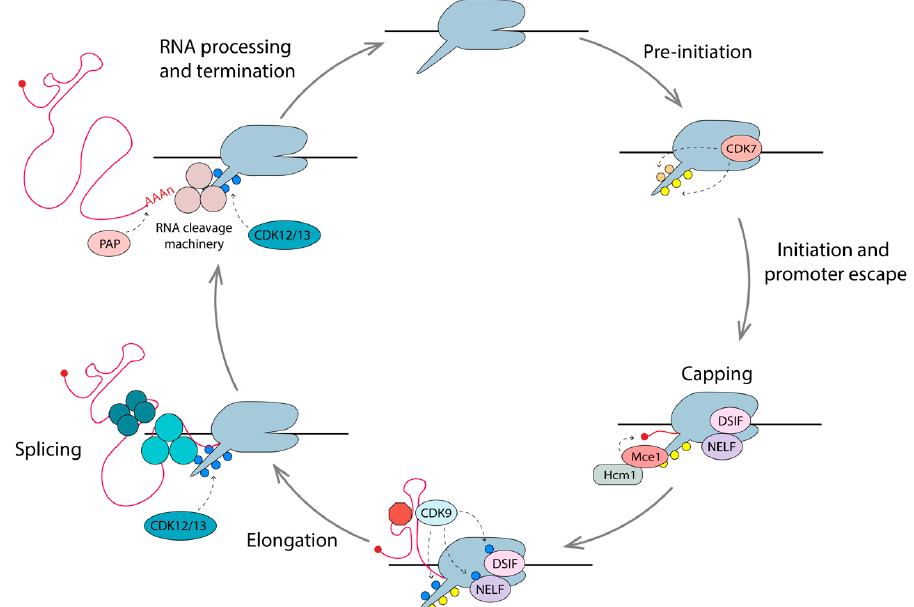
Figure 5. Transcription coupled events. Once the PIC has formed, and Ser7 and Ser5 phosphorylation of the RNAPII CTD by CDK7 (as part of TFIIH) allows initiation and promoter escape to occur. Shortly after transcription of the first 25–30 nt the 5’end of the nascent RNA is capped by the capping enzymes Mce1 and Hcm1. This process occurs more efficiently when RNAPII CTD is phosphorylated at Ser5 residues. Elongation is induced by phosphorylation events by CDK9, including CTD Ser2 phosphorylation. pSer2 is increased and RNAPII moves down the gene body by CDK12/13. This